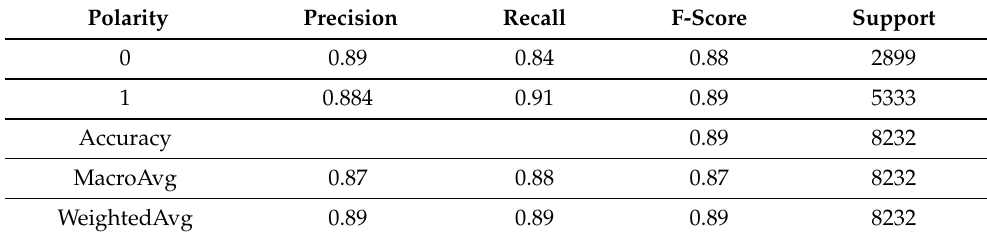
Decision Tree Classifier for multiclass classification. Training accuracy Score: